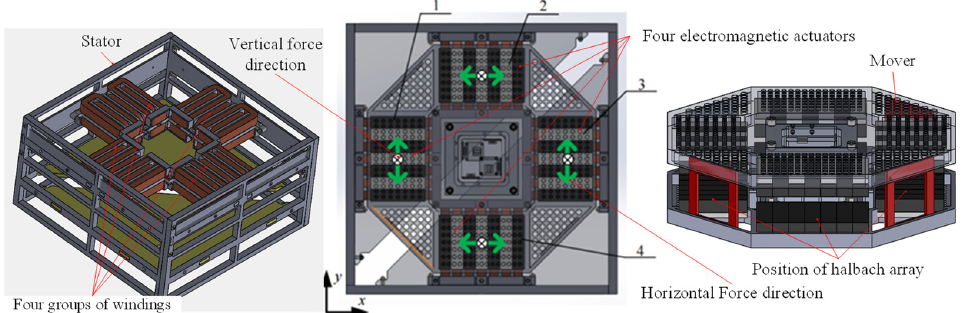
Table 1. The relationship between motion of the platform and driving forces of the actuators. Movement of the Platform